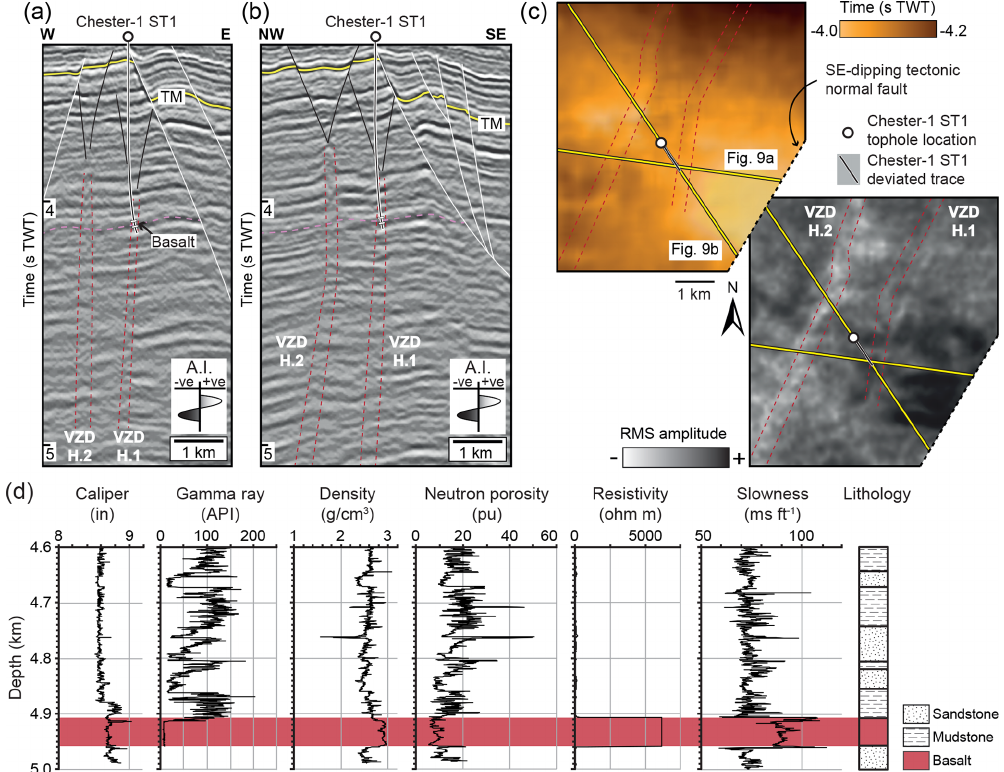
Figure 9. (a–b) Interpreted seismic sections showing the deviated trace of well Chester-1 ST1 intersecting VZD H.1. Also highlighted are the top and base of the basalt interval intersected, and its corresponding seismic horizon. See Fig. 6 for key and Fig. 9c for line locations. Uninterpreted sections provided in Fig. S7. (c) Two-way time structure and root-mean squared (rms) amplitude maps for the horizon corre- sponding to where Chester-1 ST1 intersects the basalt interval. See Fig. 4c for location. (d) Well log and lithological data from Chester-1 ST1 (Childs et al.,